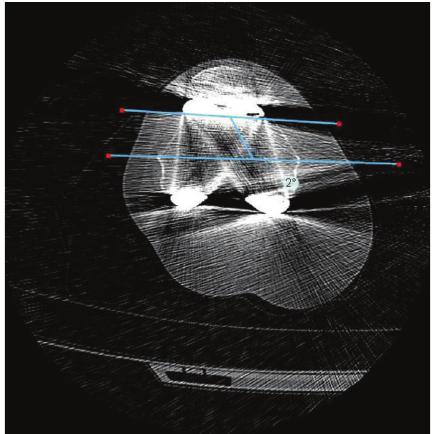
Figure 4: eLIBRA force sensor device for soft tissue balancing during TKA. Compressive forces are measured (separately at each condyle) in flexed knee position to create a balanced gap.